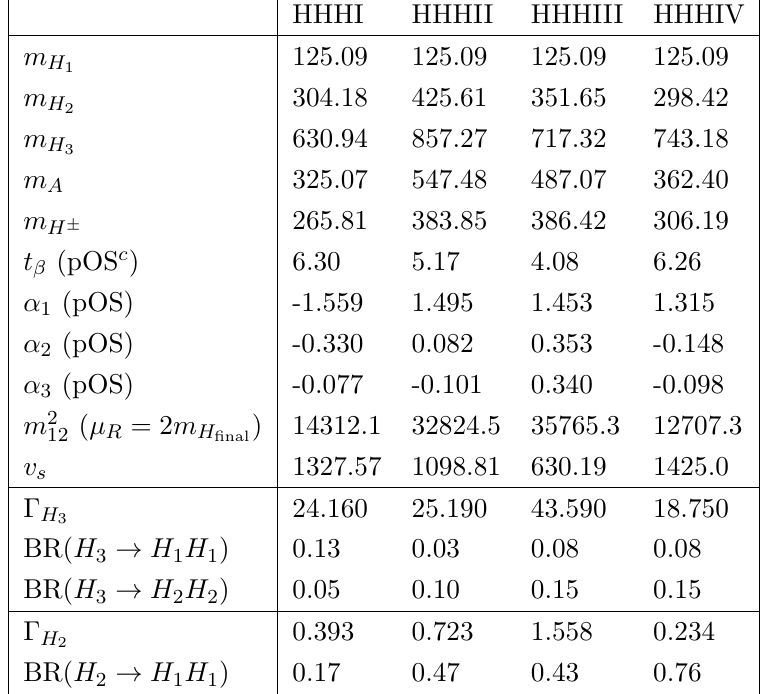
Table 10 . Input parameters for the N2HDM benchmarks used in the numerical analysis of the decay processes H j ! H i H i . All masses and v S are given in GeV. In the last (cid:12)ve rows the total H 2 and H 3 widths are given in GeV as well as the branching fractions (generated with N2HDECAY ) of the Higgs-to-Higgs decays H 3 ! H 1 H 1 ; H 2 H 2 and H 2 ! H 1 H 1